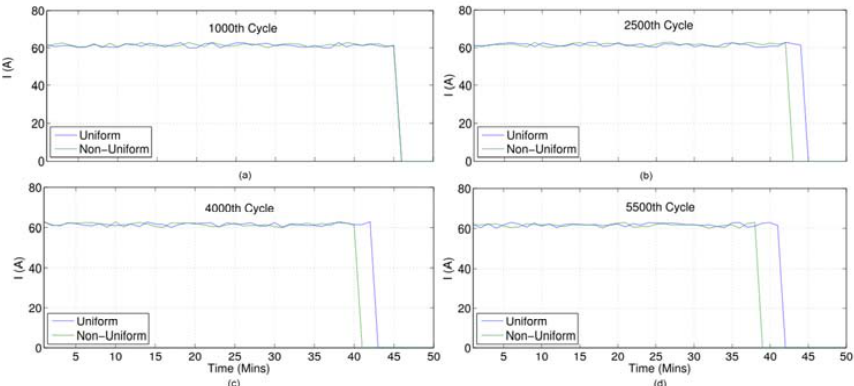
Figure 7. The charging profiles of the SBS (VRB) with uniform and non ‐ uniform aging. ( a ) 1000th Cycle; ( b ) 2500th Cycle; ( c ) 4000th Cycle; ( d ) 5500th Cycle.